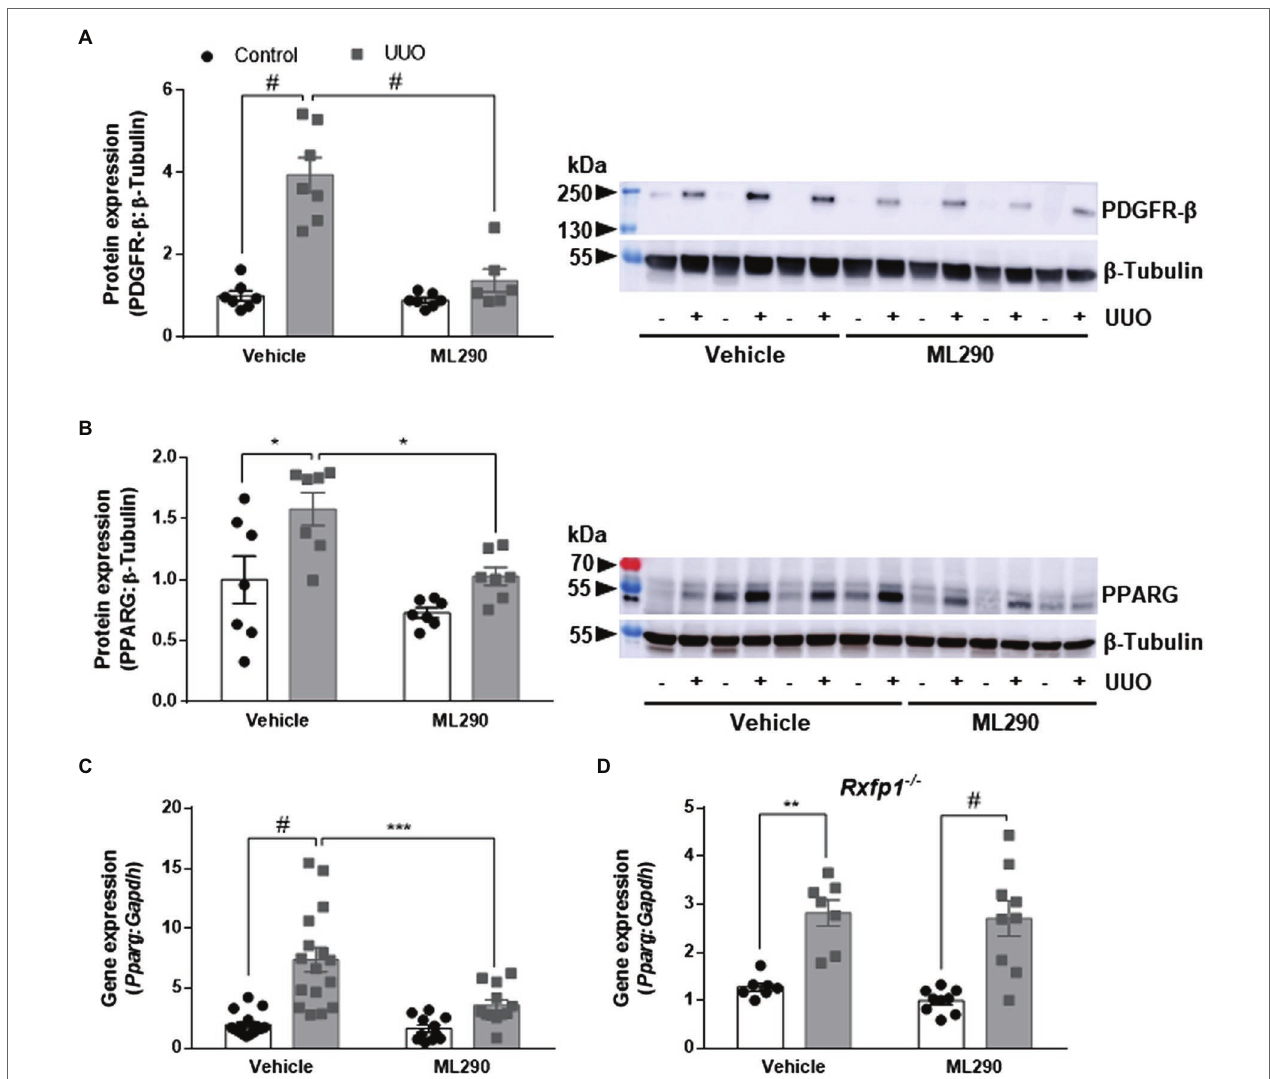
FIGURE 2 | (A,B) : Densitometry of PDGFR- β (A) (180–190 kDa) and PPARG (B) (54 kDa) protein expression in the control and UUO kidneys from vehicle- and ML290-treated humanized mice ( n = 6–7 mice/group). β -tubulin (55 kDa) was used as the loading control. (C,D) : Pparg gene expression in the control and UUO kidneys from vehicle- and ML290-treated humanized (C) ( n = 12–16 mice/group) and Rxfp1 -deficient (D) ( n = 7–9 mice/group) mice. Gene expression is normalized to the housekeeping gene Gapdh and presented as fold change to control kidneys from vehicle-treated mice. * p < 0.05, ** p < 0.01, *** p < 0.001, and # p <